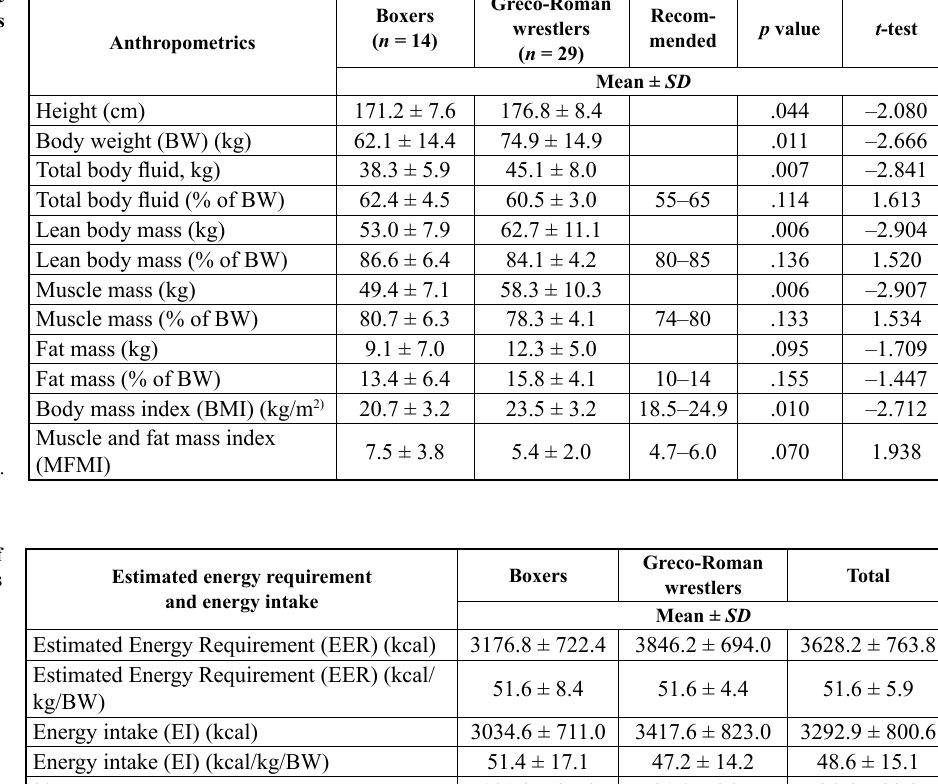
Table 1. Anthropometric data of combat sports athletes in Lithuania